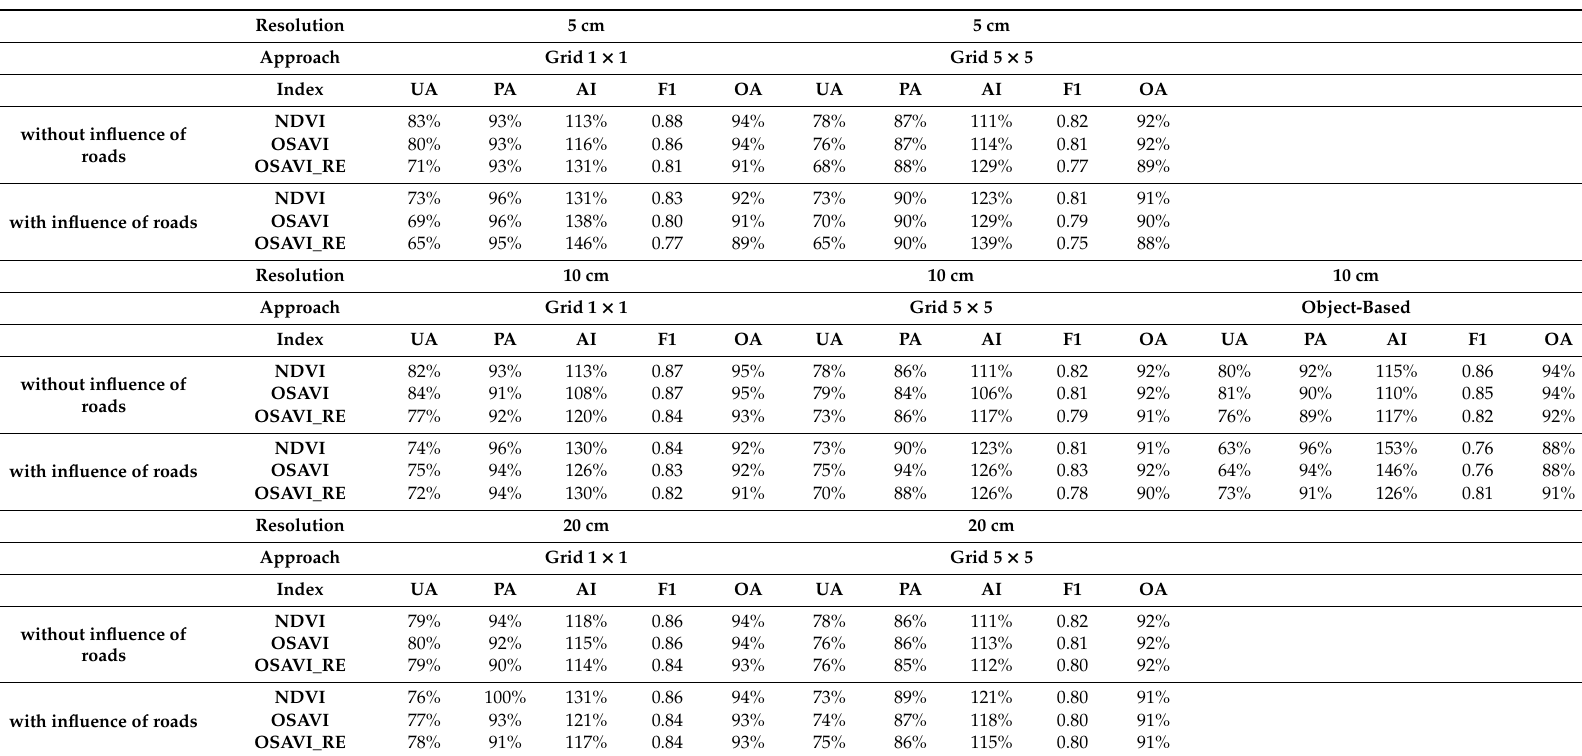
Table A1. The results of all variants within the experiment, assessed by producer’s accuracy (PA) and user’s accuracy (UA) for class damaged crops, and area index (AI), F1-score, and overall accuracy (OA) of classification for damaged crops and healthy crops. Resolution 5 cm